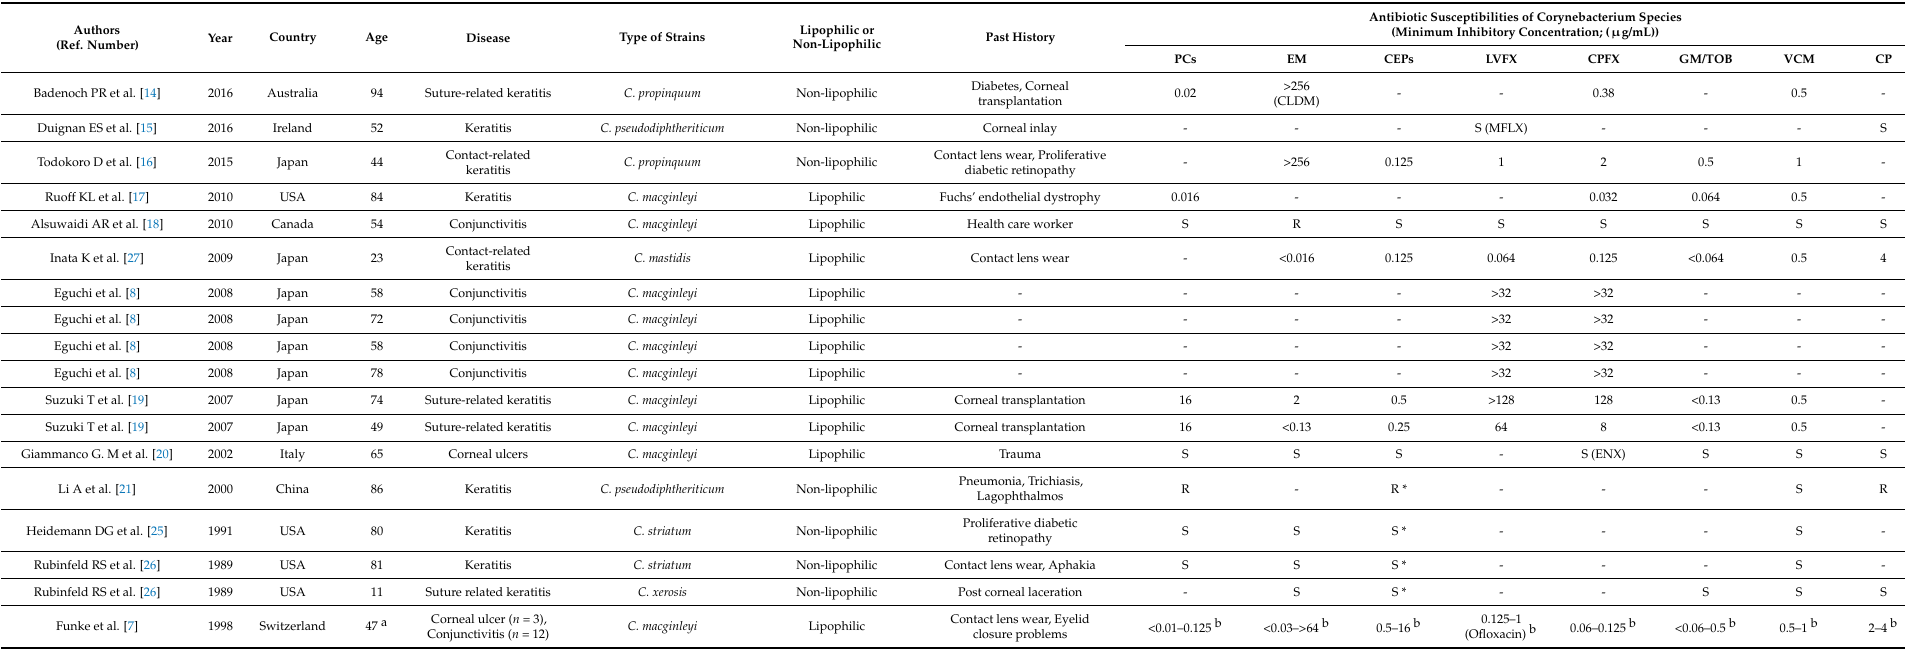
Table 1. Representative cases with ocular surface infection caused by Corynebacterium